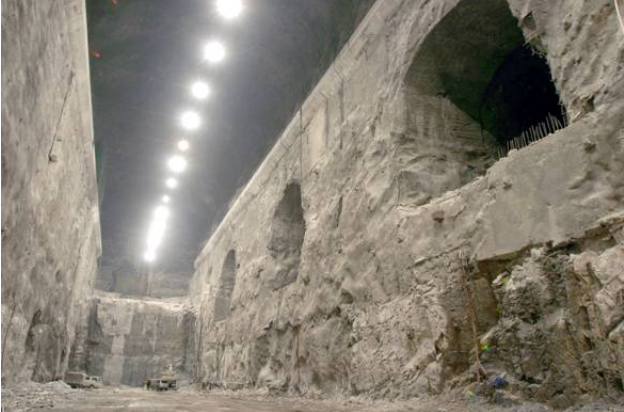
Figure 7. Photo of the excavated underground powerhouse of the Laxiwa hydropower